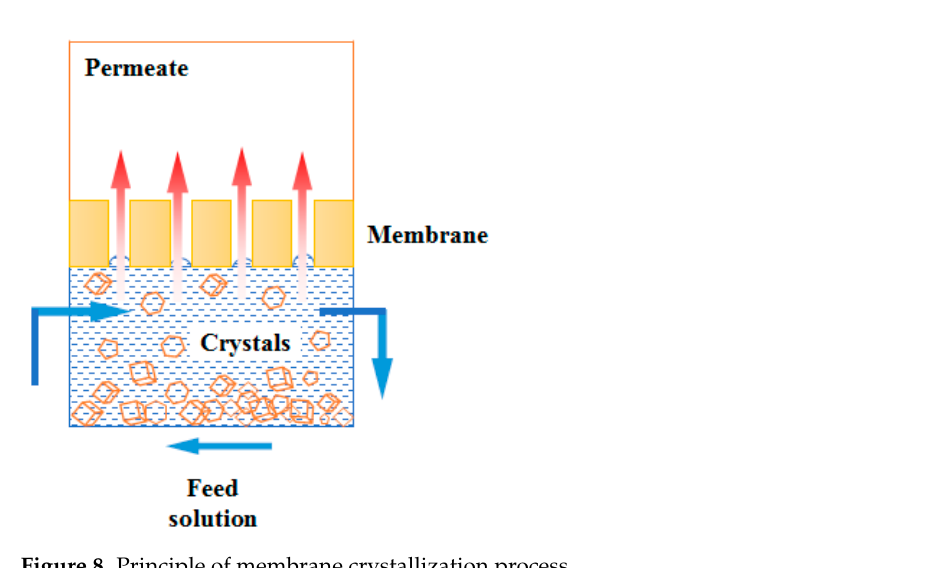
Figure 8. Principle of membrane crystallization process.